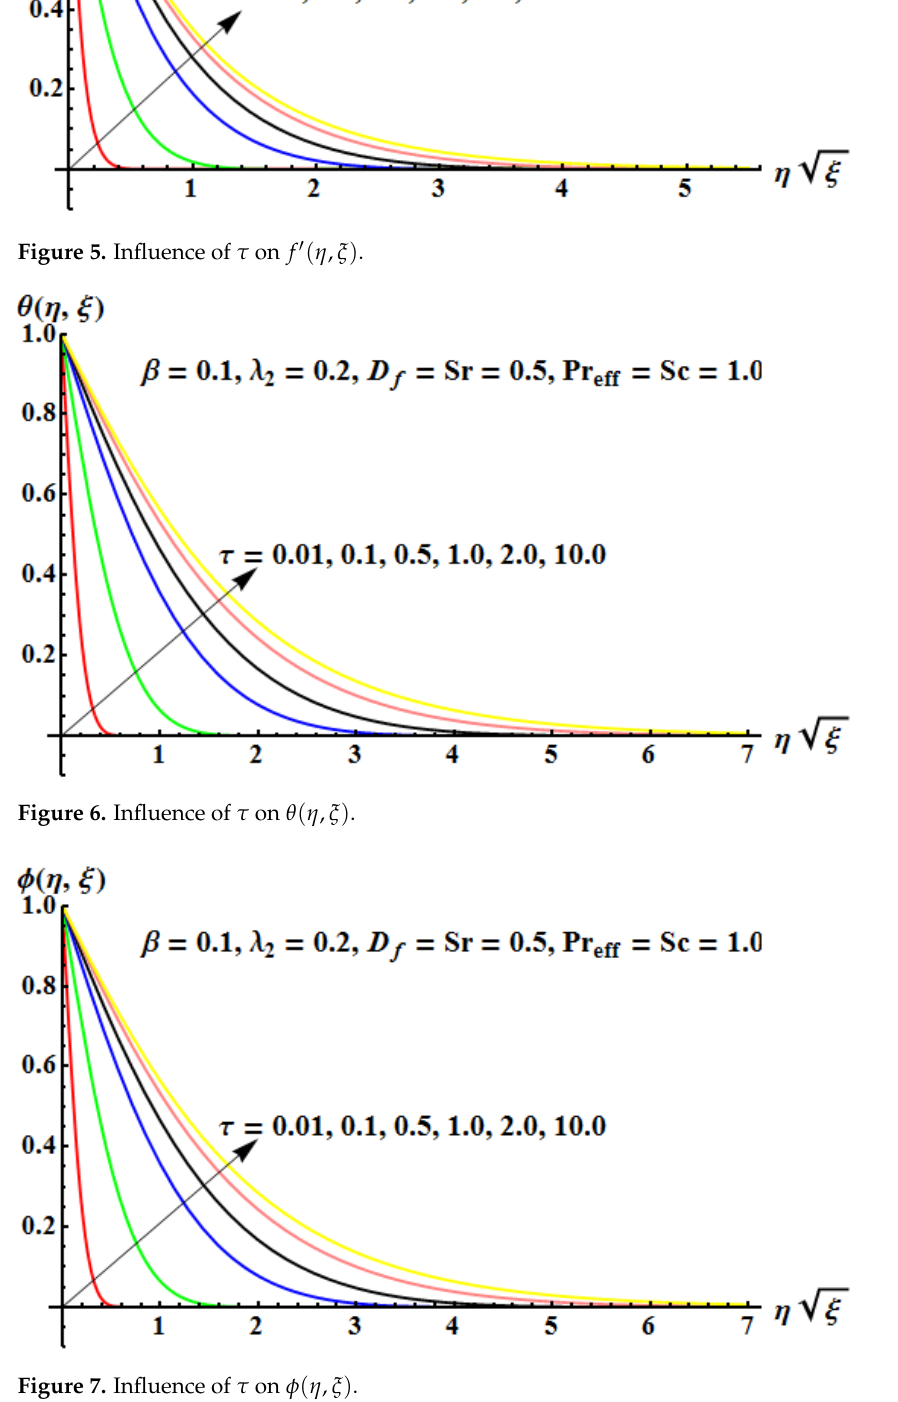
Figure 7. Influence of τ on φ ( η , ξ )